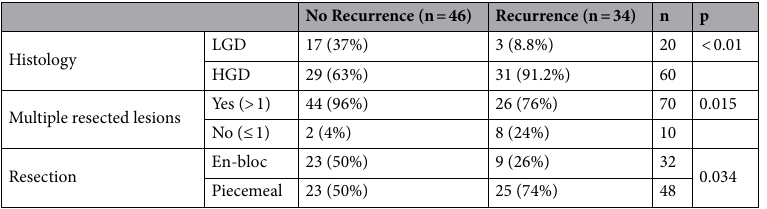
Table 6. Factors influencing local recurrence after endoscopic mucosal resection for duodenal adenoma, univariate analysis. LGD: Low-grade dysplasia; HGD: High-grade